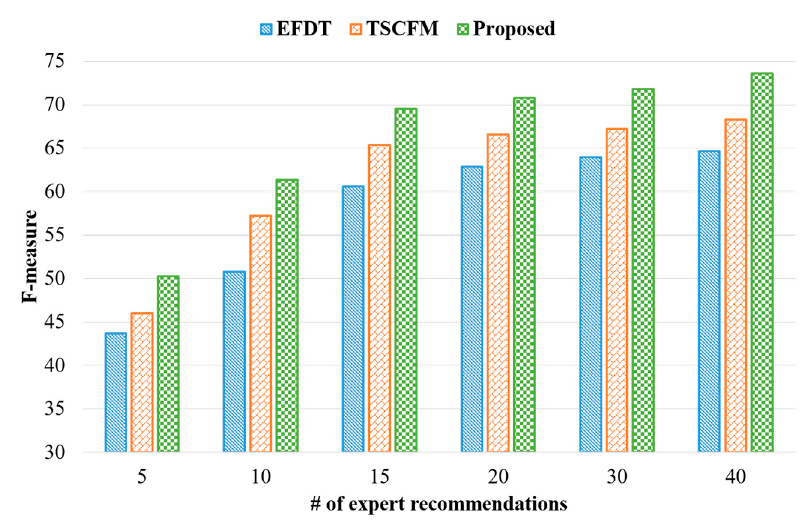
Figure 11. F-measure according to the number of expert recommendations.